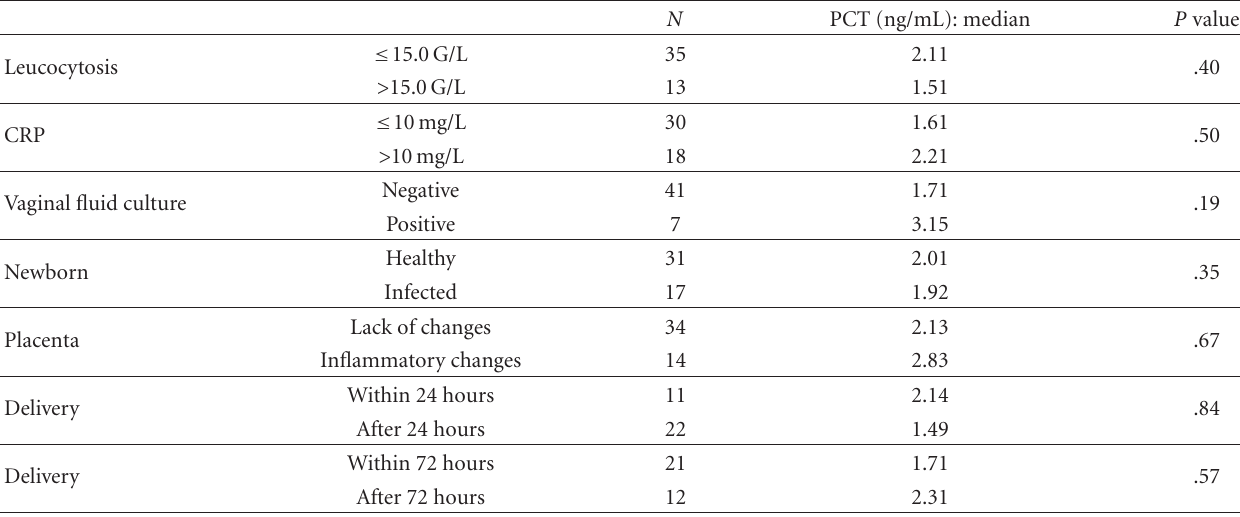
Table 3: Plasma procalcitonin (PCT) concentrations of pregnant women with pPROM in relation to the presence of indicators of the infection, newborn status, histological chorioamnionitis, and pPROM-to-delivery time.